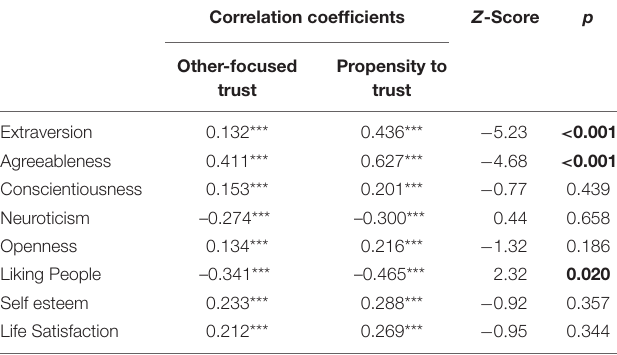
TABLE 5 | Comparison of correlation coefficients in Study